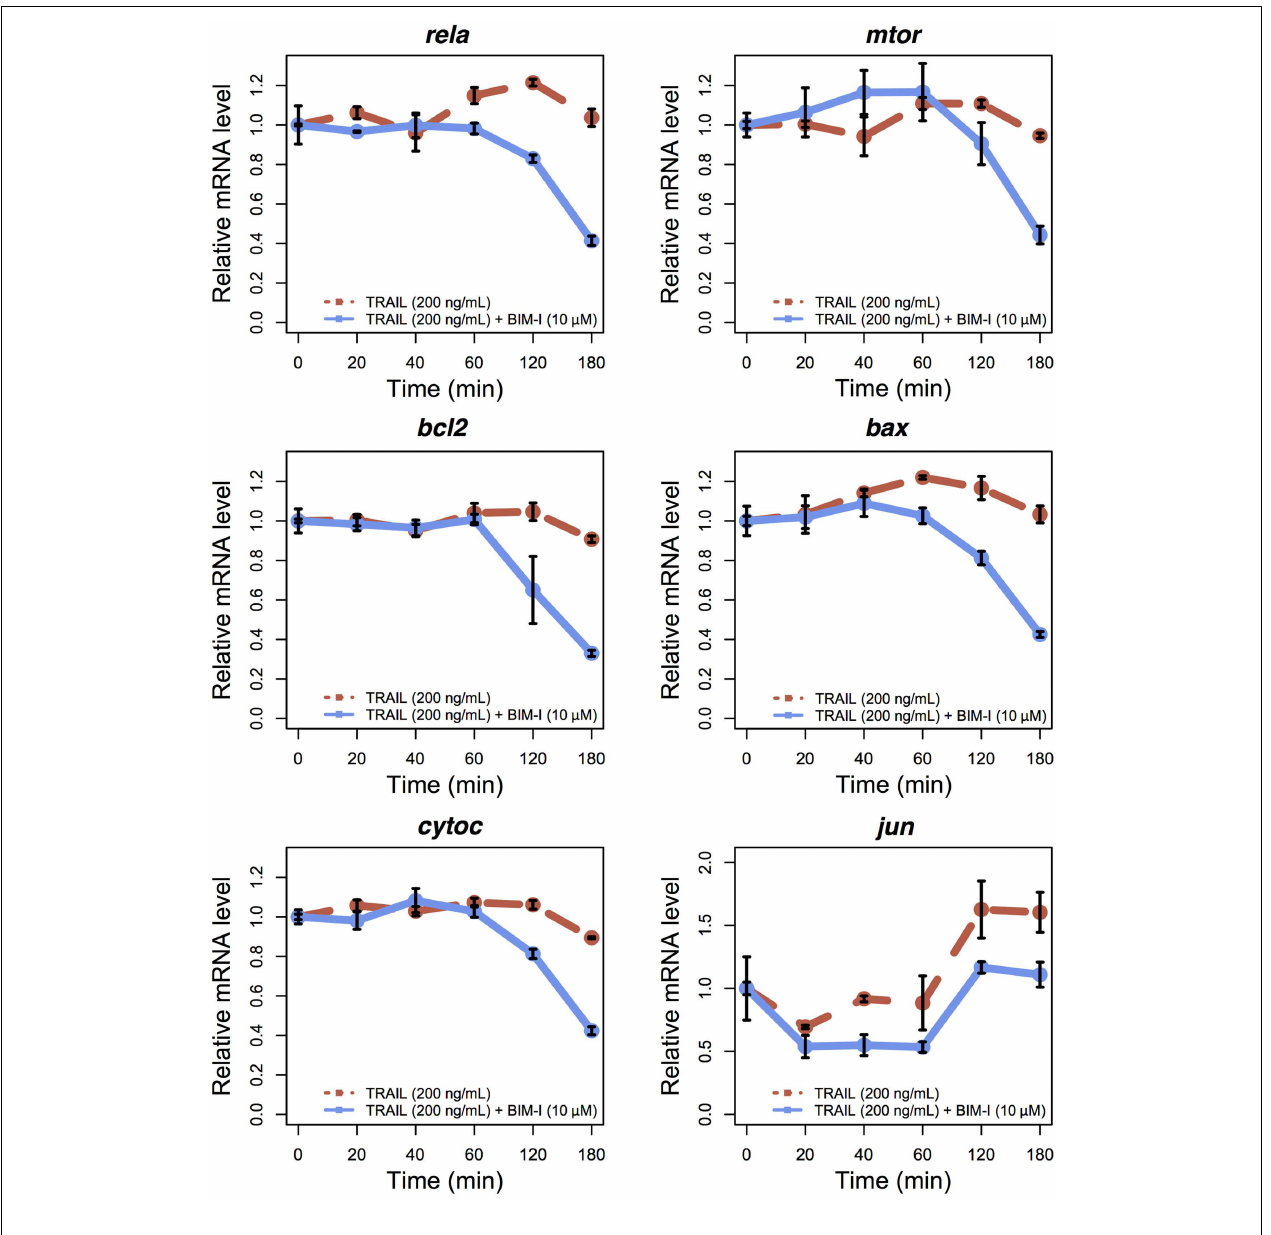
pre-treatment of BIM-I (10 µ M) 30min prior toTRAIL stimulation. Note that jun can also be considered as a pro-apoptotic gene (40). Reported values are the mean expression values ( n = 3 independent experiments) relative to time 0 of each condition. Error bars indicate mean values ±